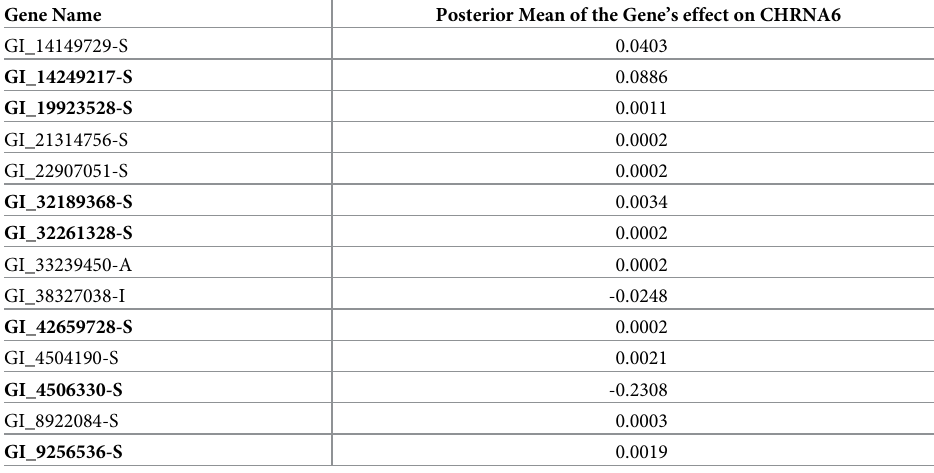
Table 2. Genes associated with CHRNA6 estimated by the DepEB